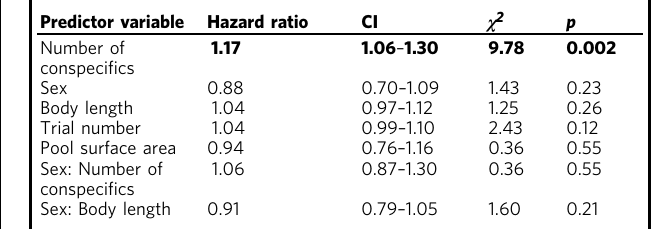
Table 2 Cox proportional hazards mixed model summary for arrival latency at a novel food